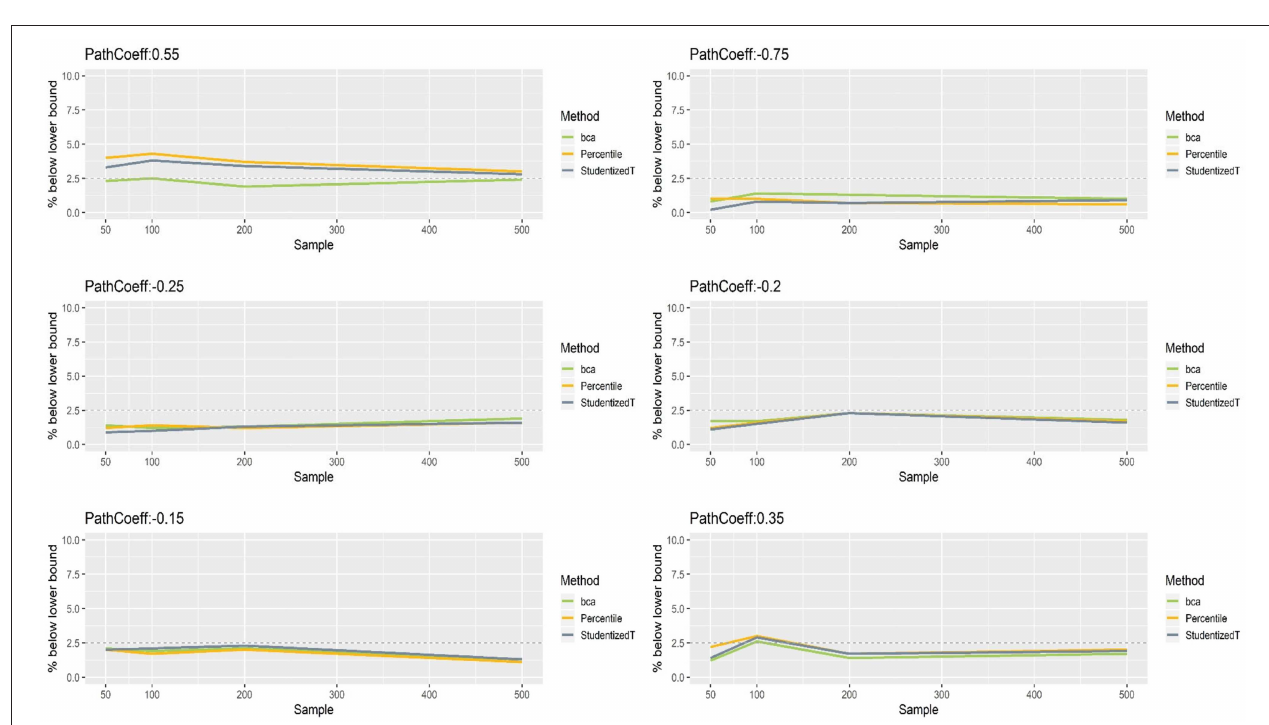
FIGURE 5 | The lower limits of percentile, bias-corrected and accelerated bootstrap (BCa), and Student’s t 95% confidence intervals (CIs) of path coefficients in the normal indicator condition.